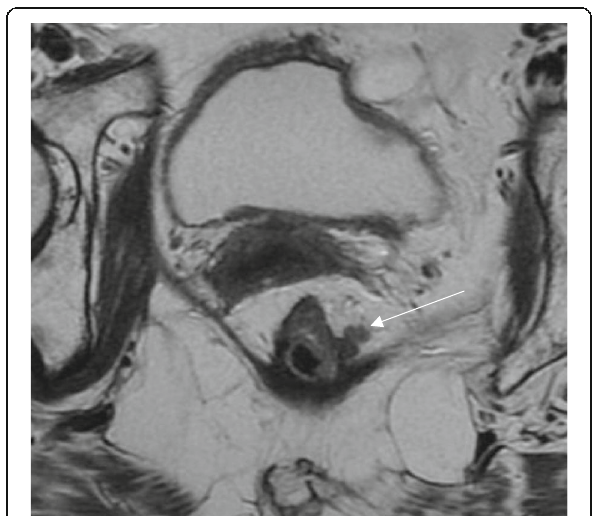
Fig. 18 Recurrence after local excision. High-resolution T2WI follow- up exam 5 years after local excision performed due to residual small lesion after CRT shows recurrent nodular lesion growing along the left rectal wall (arrow). The patient was medically unfit and aged 81 years old. Even though radical surgery was recommended, the patient refused salvage resection